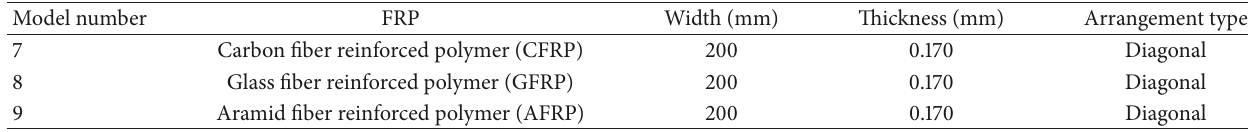
Table 8: Adopted scheme of reinforcement for different FRP